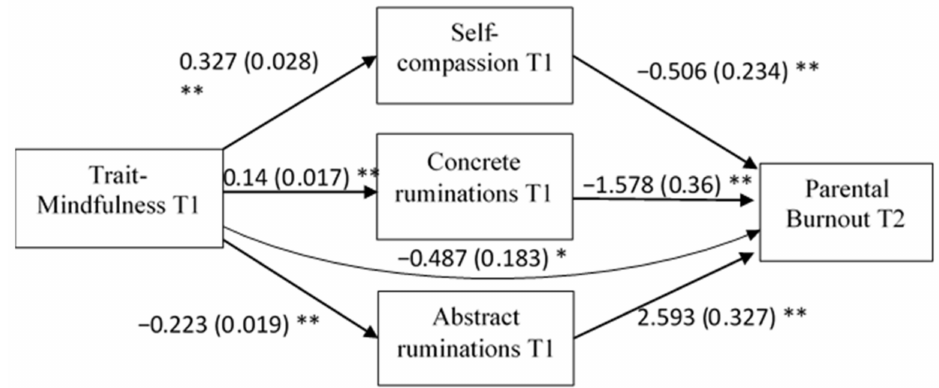
Figure 1. The self-compassion and rumination type mediation model of the relationship between mindfulness and parental burnout. Note: N = 459. Standardized regression coefficients for the relationship between trait-mindfulness, self-compassion, concrete ruminations, abstract ruminations, and pa-rental burnout. Standard errors are in brackets. * p < 0.01, ** p < 0.001. The data were analysed with